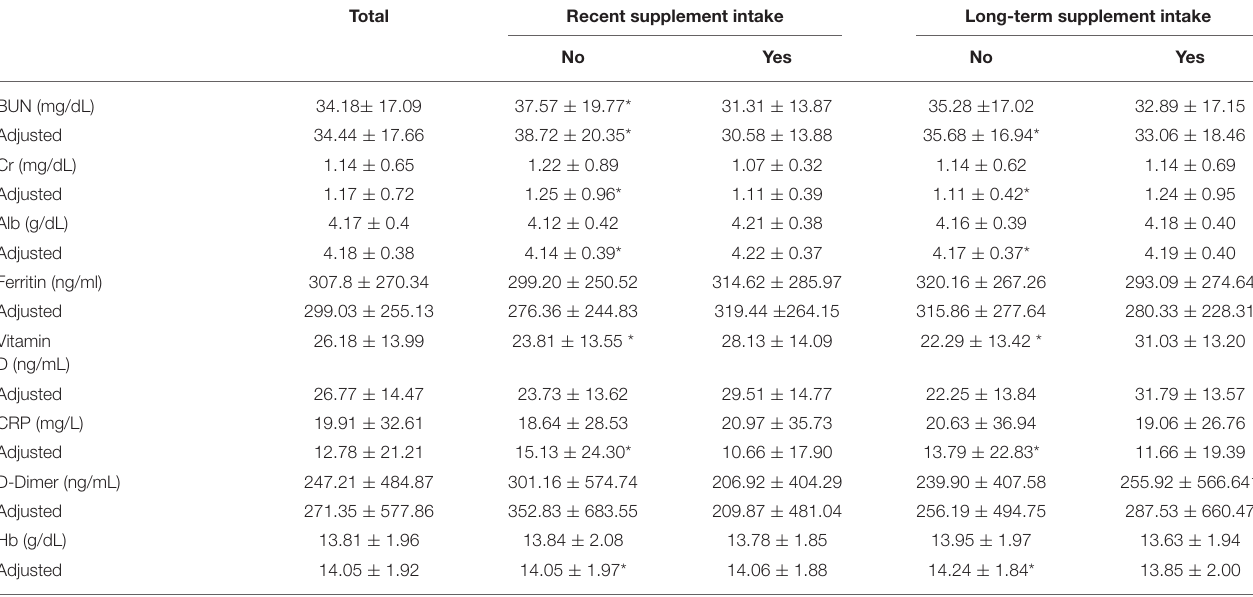
TABLE 3 | Important parameters in patients with COVID-19 in different supplement intake